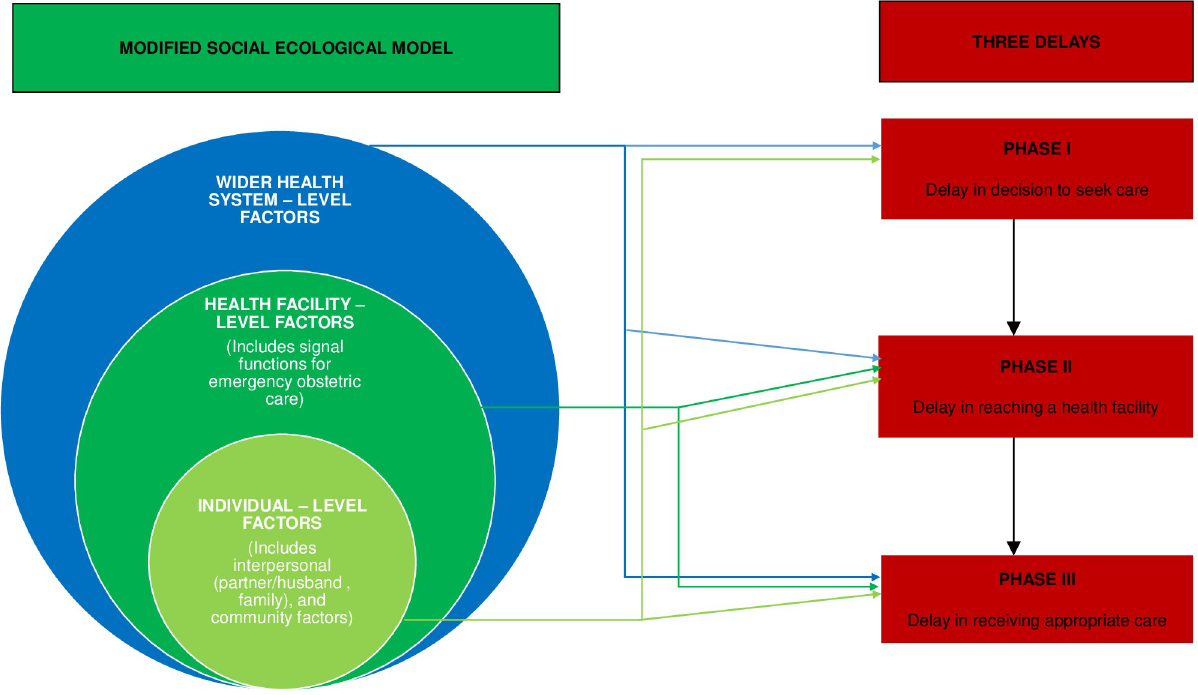
Fig 1. Conceptual framework. A modification of the social-ecological model into three levels of contributing factors: Individual, health facility and wider health system levels and their linkage to the three delays framework.